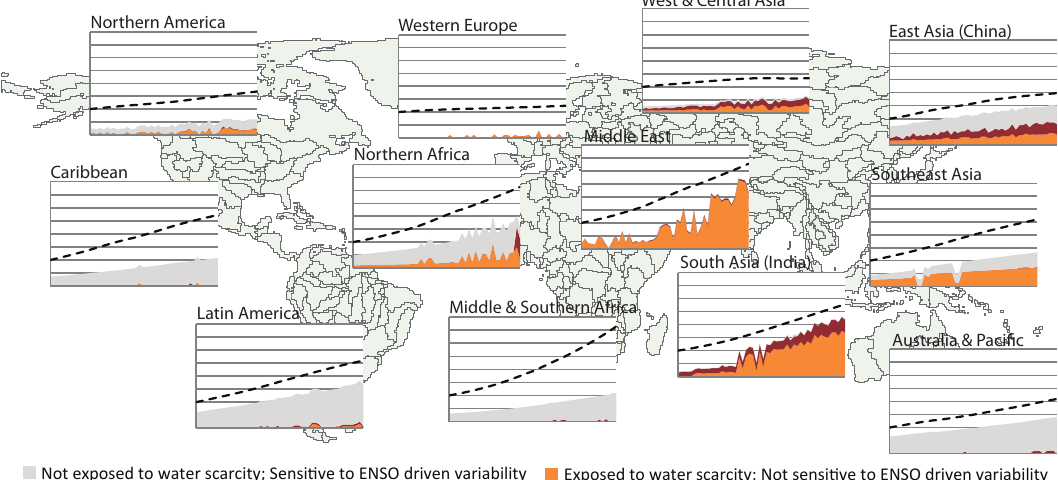
Figure 5. Regional variation in developments of population (%) exposed to water scarcity events and/or being sensitive to ENSO-driven climate variability over the period 1961–2010, as estimated with the CTA ratio. The figure shows per world region the growth in population living under water scarcity conditions and/or living in areas sensitive to ENSO-driven climate variability, relative to the total growth in global population (set at 100 in 1961). Y axis (% population) ranges from 0 up to 400.